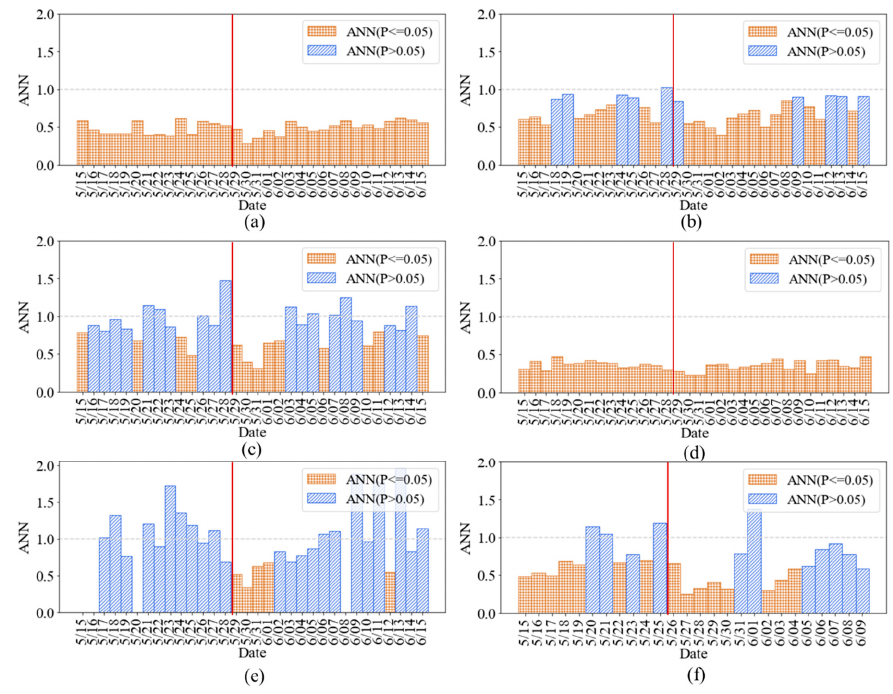
Figure 6. Average nearest neighbor value ( a ) Los Angeles County, CA; ( b ) New York City, NY; ( c